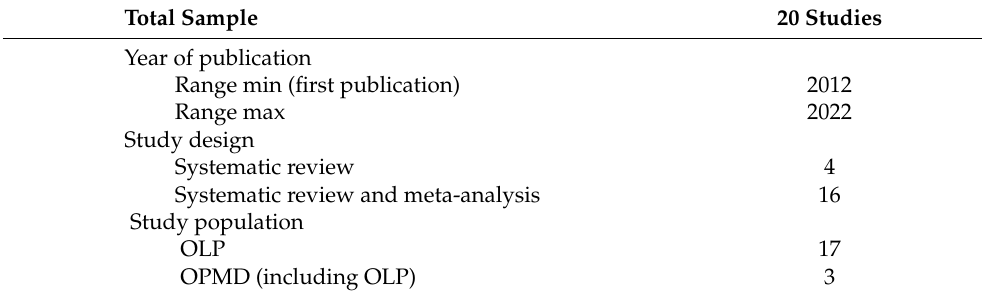
Table 1. Summarized study characteristics.